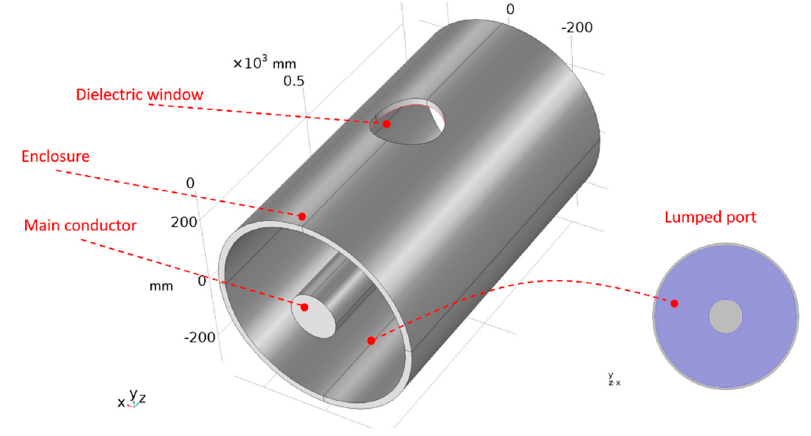
Figure 3. Simulation model geometry. Table 1. Model dimensions.